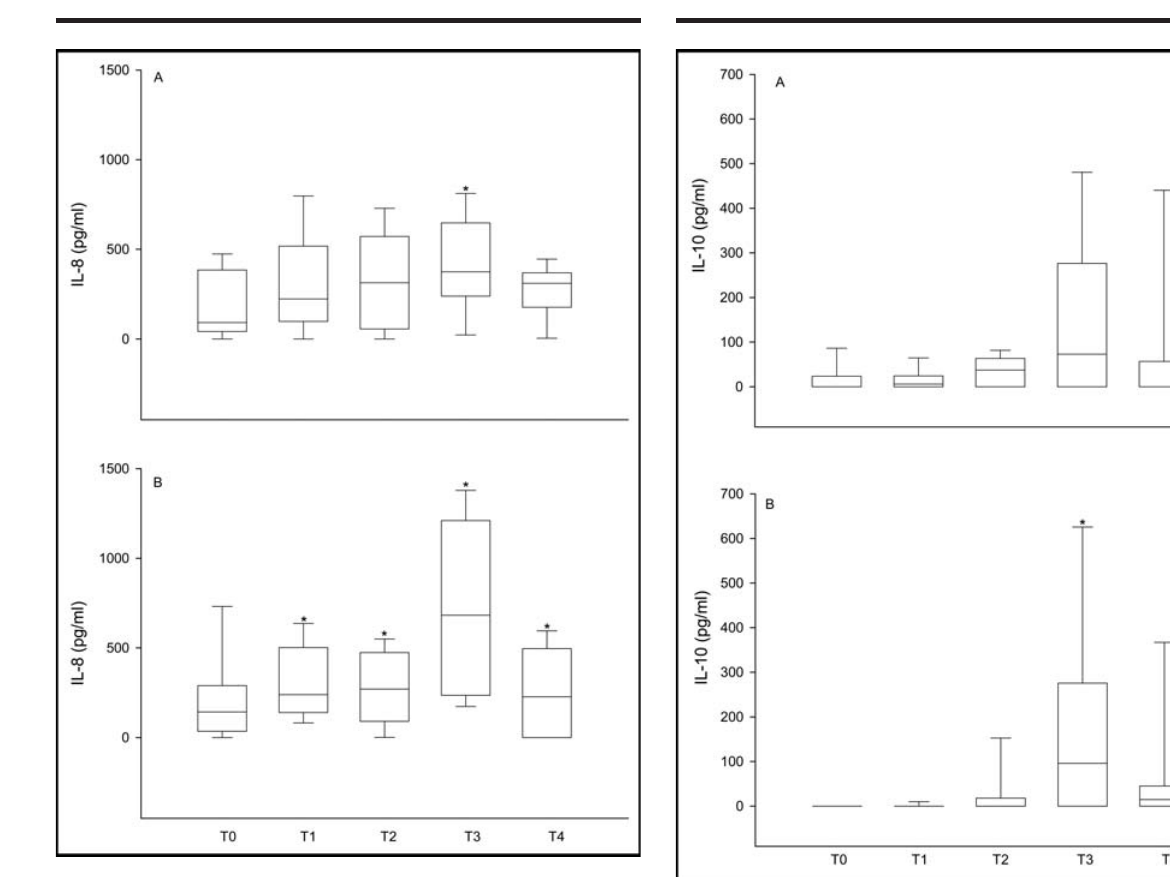
FIGURE 2 - Plasma IL-8 concentrations during and after bypass. Patients were submitted to bypass under normothermia with blood cardioplegia (n=10, panel A) or hypothermia with crystalloid cardioplegia (n=10, panel B).